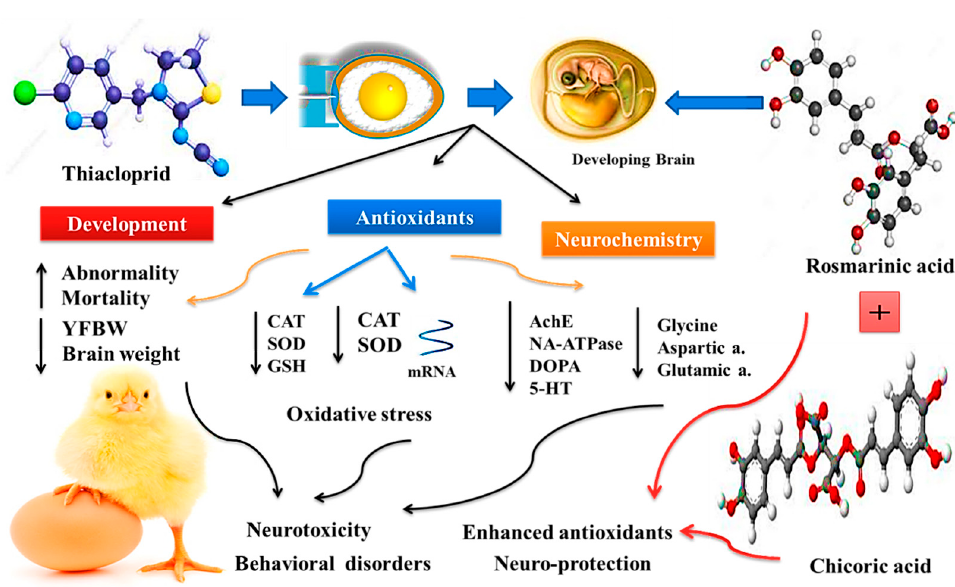
Figure 4. Effect of chicoric (CA) and rosmarinic acids (RA) exposure on suppression of developmental neurotoxicity of thiacloprid (TH) in chicken embryos.